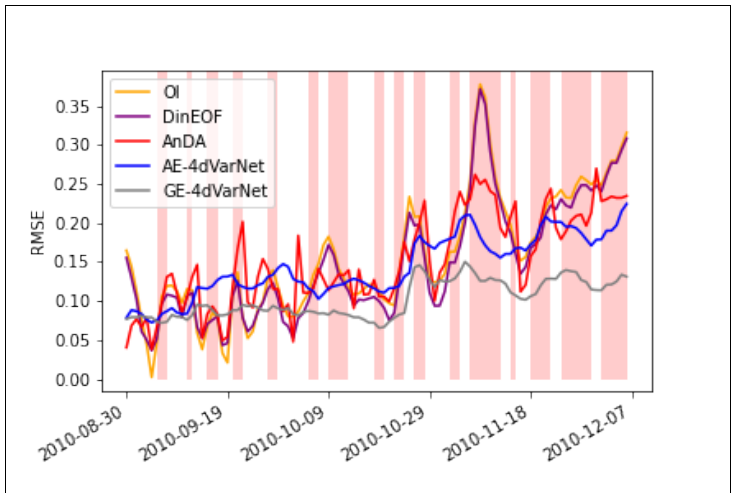
Figure 4. Daily reconstruction RMSE for OI, DinEOF, AndA, AE-4DVarNet, and GE-4DVarNet. Red bars indicate time periods having a daily missing data rate above